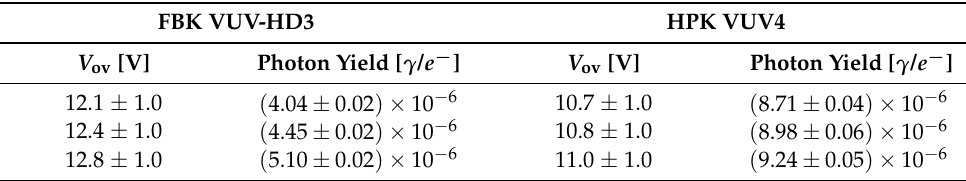
Table 5. Photon yields (number of photons emitted per charge carrier) measured in the wavelength range [450–1020] nm for the FBK VUV-HD3 and HPK VUV4 SiPMs as a function of the applied over-voltage. The last line of the table represents the photon yields measured in [15,24], respectively. FBK VUV-HD3 HPK VUV4